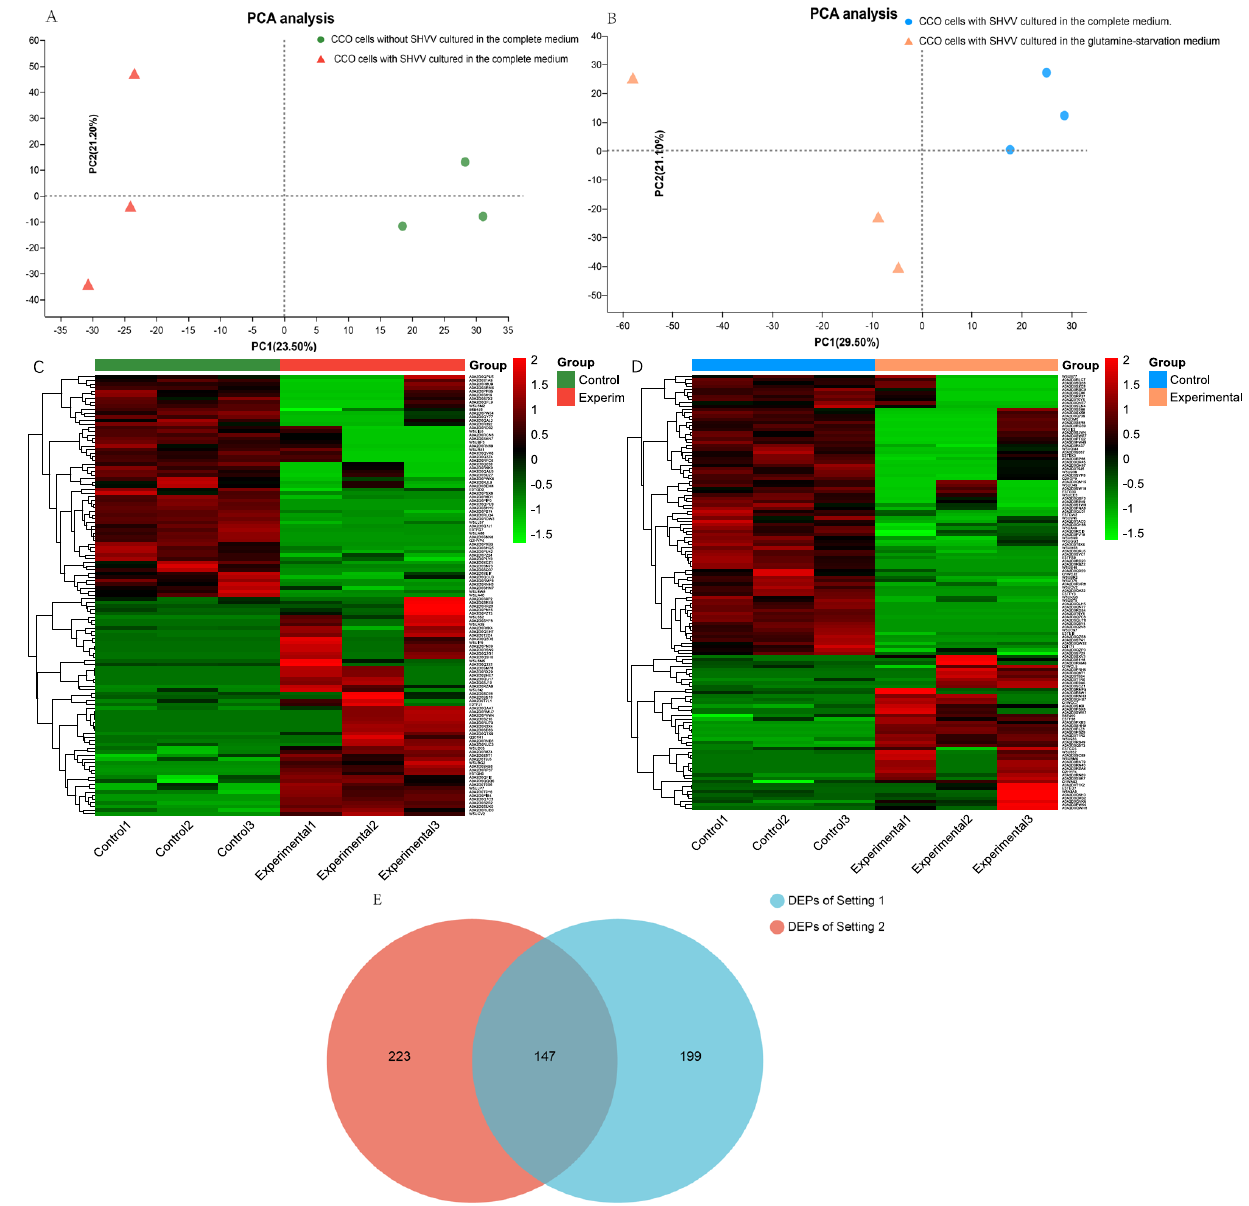
Figure 1. ( A , B ) The principal component analysis (PCA) models of each experimental group. ( A ) Samples from CCO cells with or without SHVV cultured in the complete medium. ( B ) Samples from CCO cells with SHVV cultured in the glutamine-starvation medium or the complete medium. ( C , D ) Heatmaps of DEPs identified with fold change >2 or <0.5, p -value < 0.05). ( C ) Heatmap of experimental setting 1. Control: DEPs from CCO cells without SHVV were cultured in the complete medium. Experimental: DEPs from CCO cells with SHVV were cultured in the complete medium. ( D ) Heatmap of experimental setting 2. Control: DEPs from CCO cells with SHVV cultured in the complete medium. Experimental: DEPs from CCO cells with SHVV cultured in the glutamine-free medium (E) Venn diagram of DEPs between the two experimental groups.